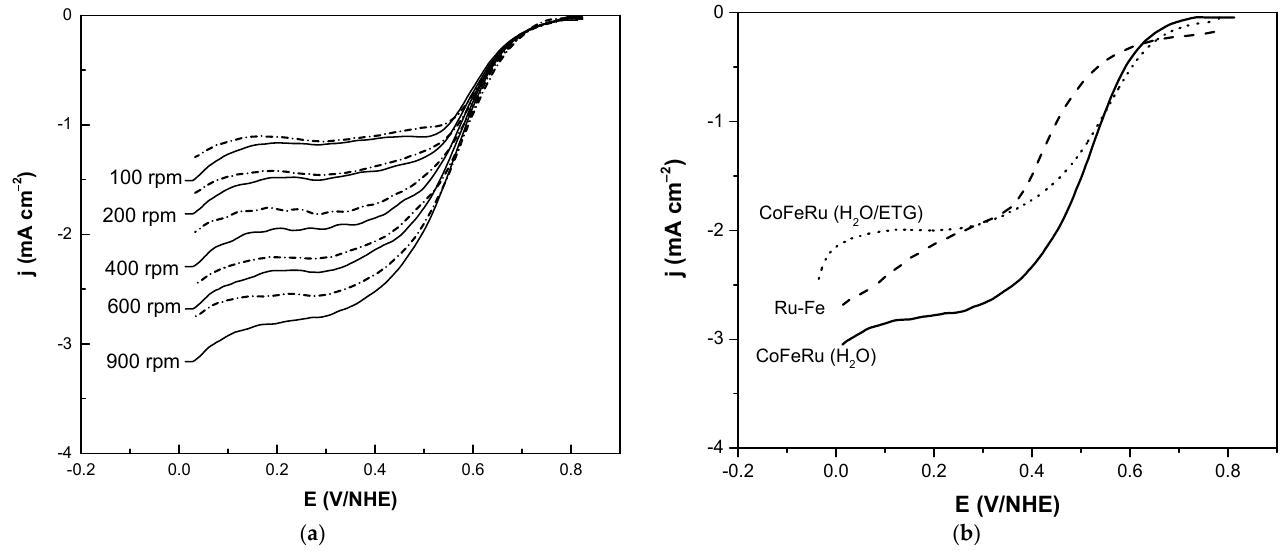
Figure 5. Linear sweep voltammograms for the oxygen reduction of ( a ) CoFeRu/C electrocatalyst without (solid line) and with (dash line) 2 mol L − 1 methanol; ( b ) CoFeRu (H 2 O), CoFeRu (H 2 O/ETG) and Ru-Fe reported in the literature at 900 rpm. The sweep rate was 5 mV s − 1 and as electrolyte 0.5 mol L − 1 H 2 SO 4 .